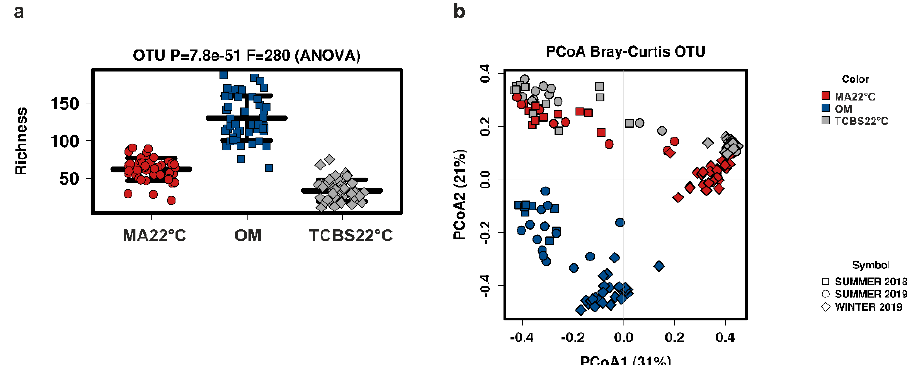
Figure 2. 16S amplicon-based microbial diversity of clam samples. ( a ) 16S amplicon-based alpha diversity tested with ANOVA according to Richness Index. ( b ) 16S amplicon-based microbial principal coordinate analysis (PCoA) representation of homogenate and plated clam samples according to the Bray–Curtis Index. In PCoA representation, the season factor corresponding to the collection time of clam samples is also reported. OM: Homogenate clam samples; MA 22 ◦ C: clam samples plated on marine agar and incubated at 22 ◦ C; TCBS 22 ◦ C: clam samples plated on thiosulfate-citrate-bile salts-sucrose agar and incubated at 22 ◦ C.